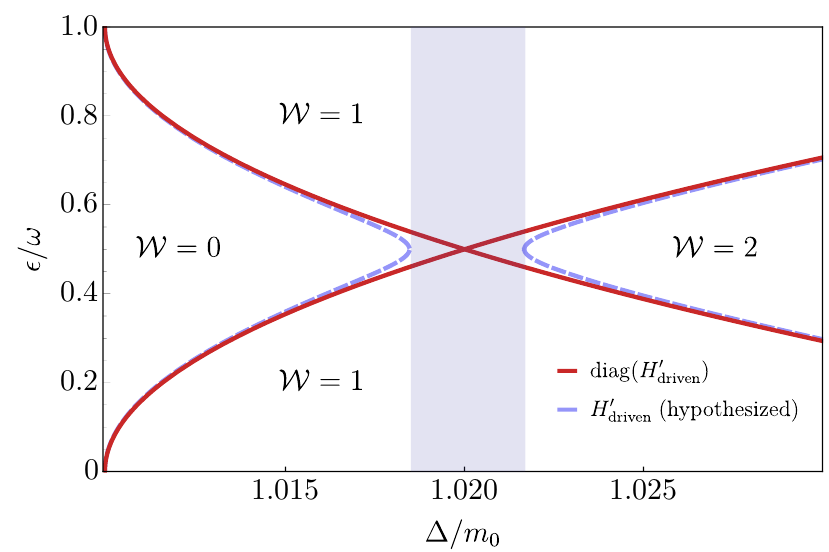
Figure 5: Phase diagram for the driven system as a function of ∆ and the quasienergy ε at a fixed driving frequency ω , in the presence of random potential disorder. The red lines show the delocalized energies obtained by setting the off-diagonal blocks in Eq. (19) to zero. The blue dashed lines schematically indicate the expected locations [ Eq. (19) ] including the off-diagonal blocks. of the delocalized quasienergies for H (cid:48) eff In this case, the blue shaded region is in the AFAI phase, as can be seen from the fact that in this region, W = 1 for all quasi-energies. For a material with a fixed value of ∆ and m , the resonant driving frequency can be obtained via Eq. (21). The 0 = A = 0.1 m following parameters were used in the figure: A , ω = 0.24 m , and 0 1 0 0 / m B = 0.5 v 2 0 F